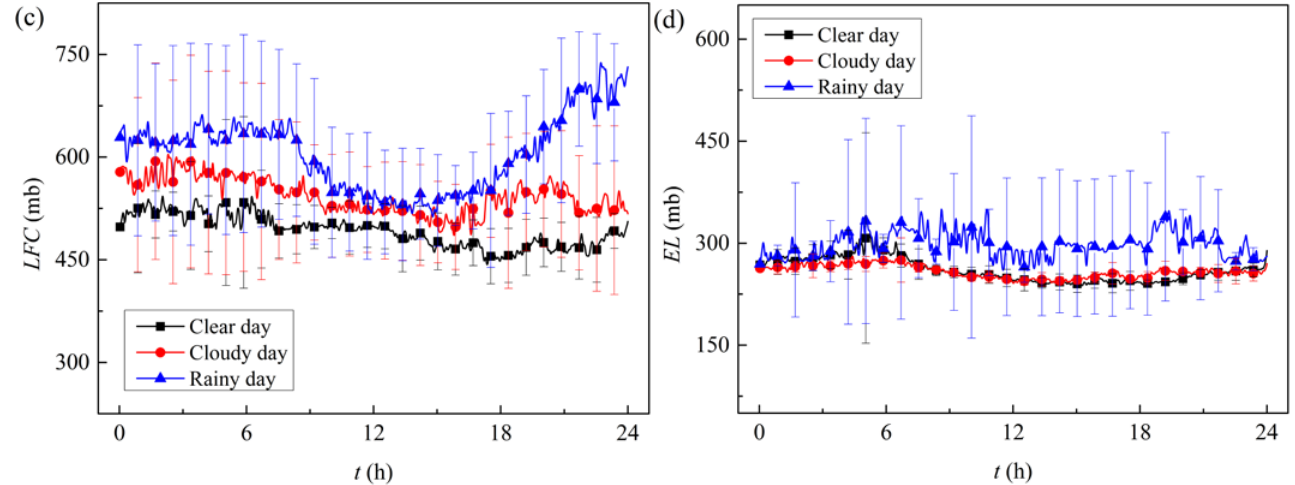
Figure 6. Statistical characteristics of parcel heights (whole day, monsoon season) under different weather conditions. ( a ) CCL , ( b ) LCL , ( c ) LFC , ( d ) EL . The t (h) is expressed in UTC+8.